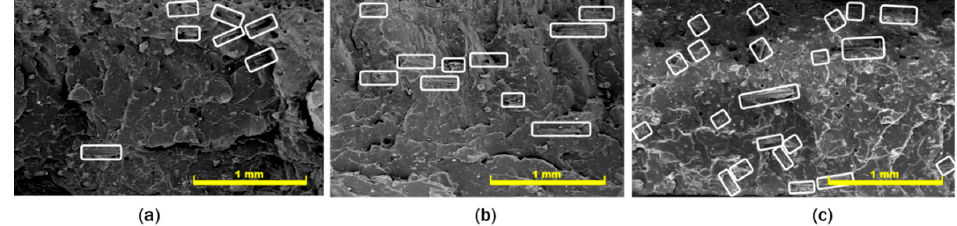
Figure 5. Field Emission-Scanning Electron Microscope (FE-SEM) images of fractural cross-section on natural fiber (NF) filled NR composites that were added with NR-g-St at compositions of ( a ) 0 phr, ( b ) 1 phr, and ( c ) 2 phr. All images are at 100 (cid:3400) magnification. ( b ) 1 phr, and ( c ) 2 phr. All images are at 100 ×